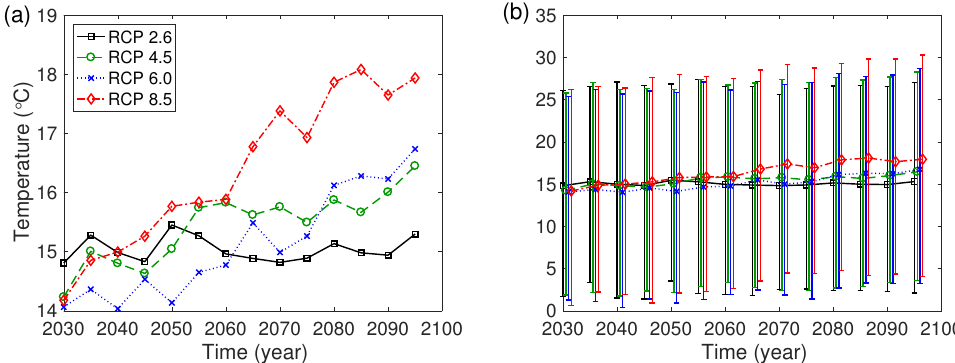
Figure A1. ( a ) Daily mean temperature for five years. ( b ) Range from the mean temperature in the summer (June to August) to the mean temperature in the winter (December to February) for five